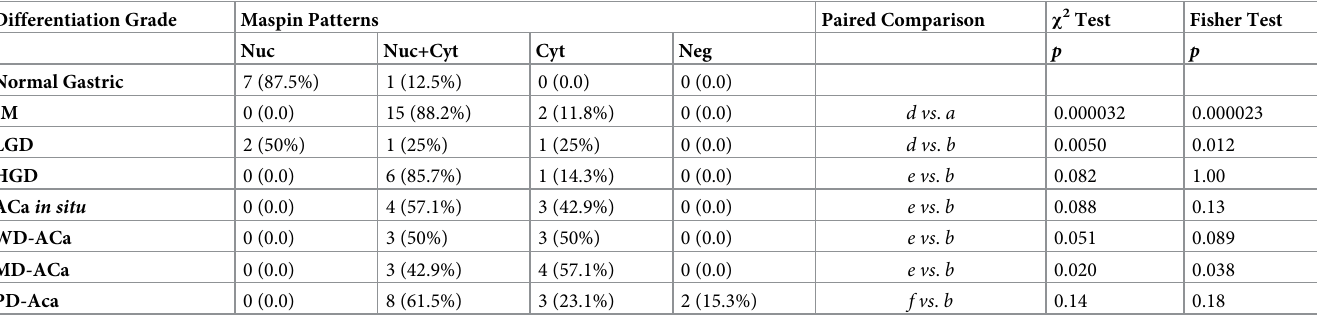
Table 2. Statistical analysis of the differential maspin